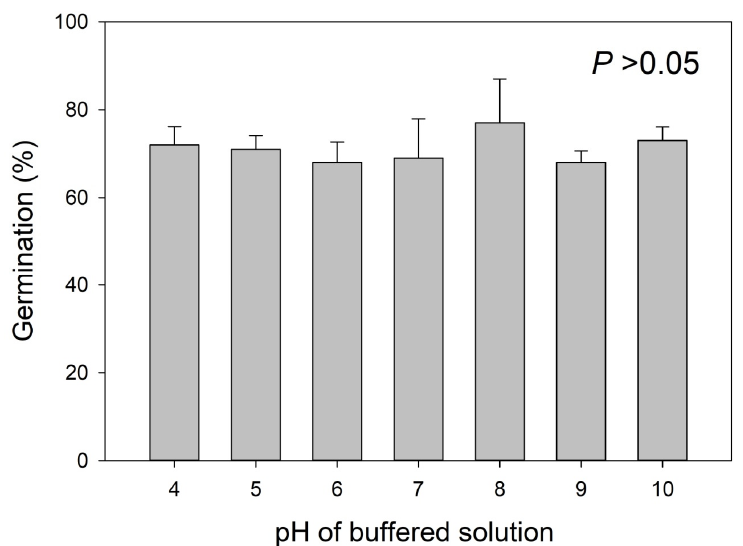
Figure 4. Impact of buffered pH solutions on white clover seed germination incubated in growth chambers set for a constant temperature of 20 ◦ C and a 12 h photoperiod with a light intensity of 200 µ mol m − 2 s − 1 and 70% relative humidity. Results were pooled over two experimental runs. Vertical bars represent standard errors ( n =